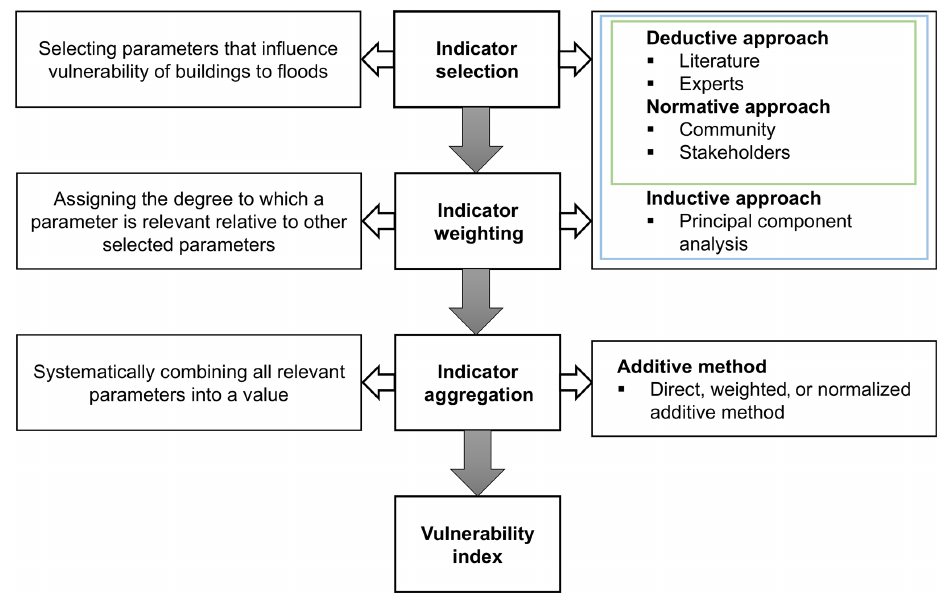
Figure 1. Steps and commonly applied methods for developing a physical flood vulnerability index. Steps include the indicator selection, the indicator weighting, and the indicator aggregation. The green box applies to initial indicator selection, and the blue box applies to final indicator